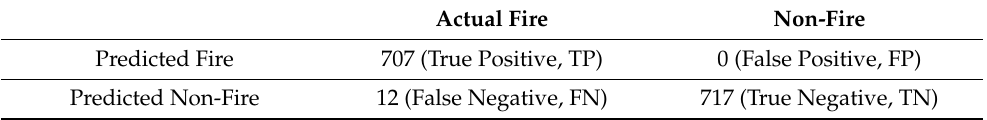
Table 4. Experimental confusion matrix.